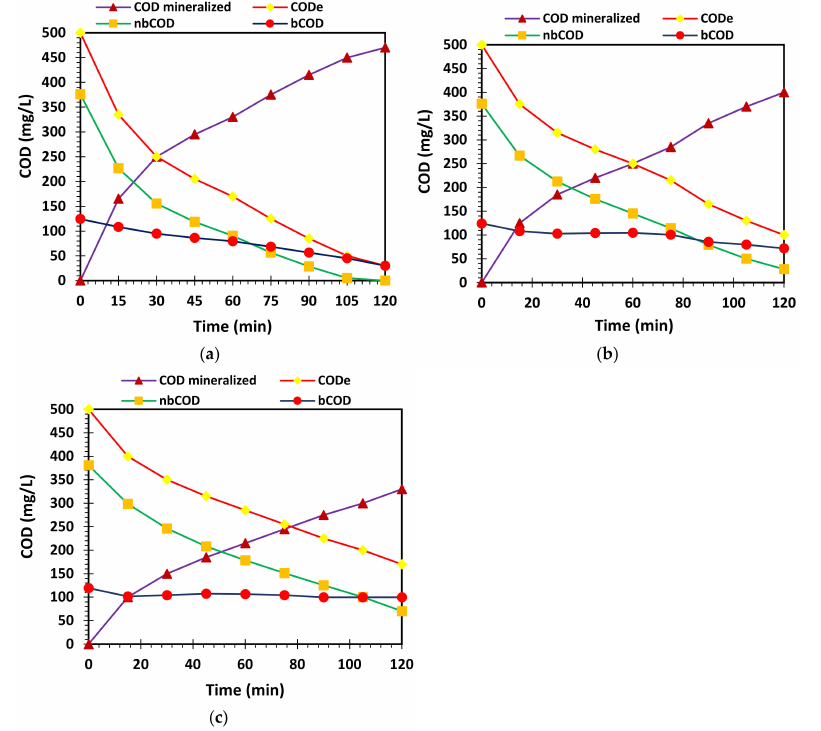
Figure 2. COD removal by ( a ) L − Histidine (2 wt.%) − TiO 2 ( b ) L − Methionine (1.5 wt.%) − TiO 2 ( c ) L − Asparagine (2 wt.%) − TiO 2 at catalyst loading of 2 g/L, COD concentration of 500 mg/L and original pH =